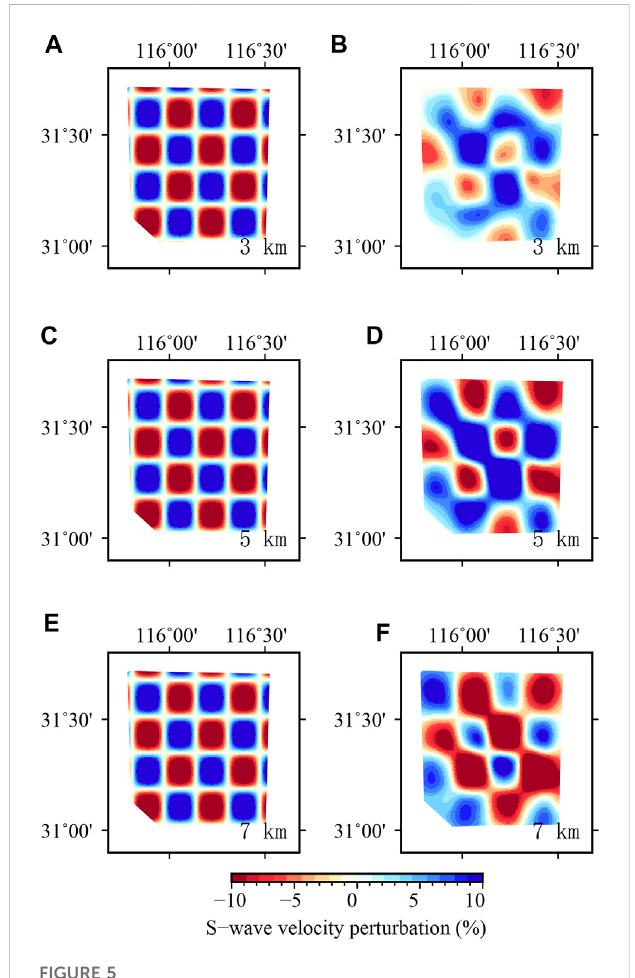
FIGURE 5 Theoretical results of Checkerboard test in horizontal slices (A, C, E) : Real model; (B, D, F) : Inverted model.